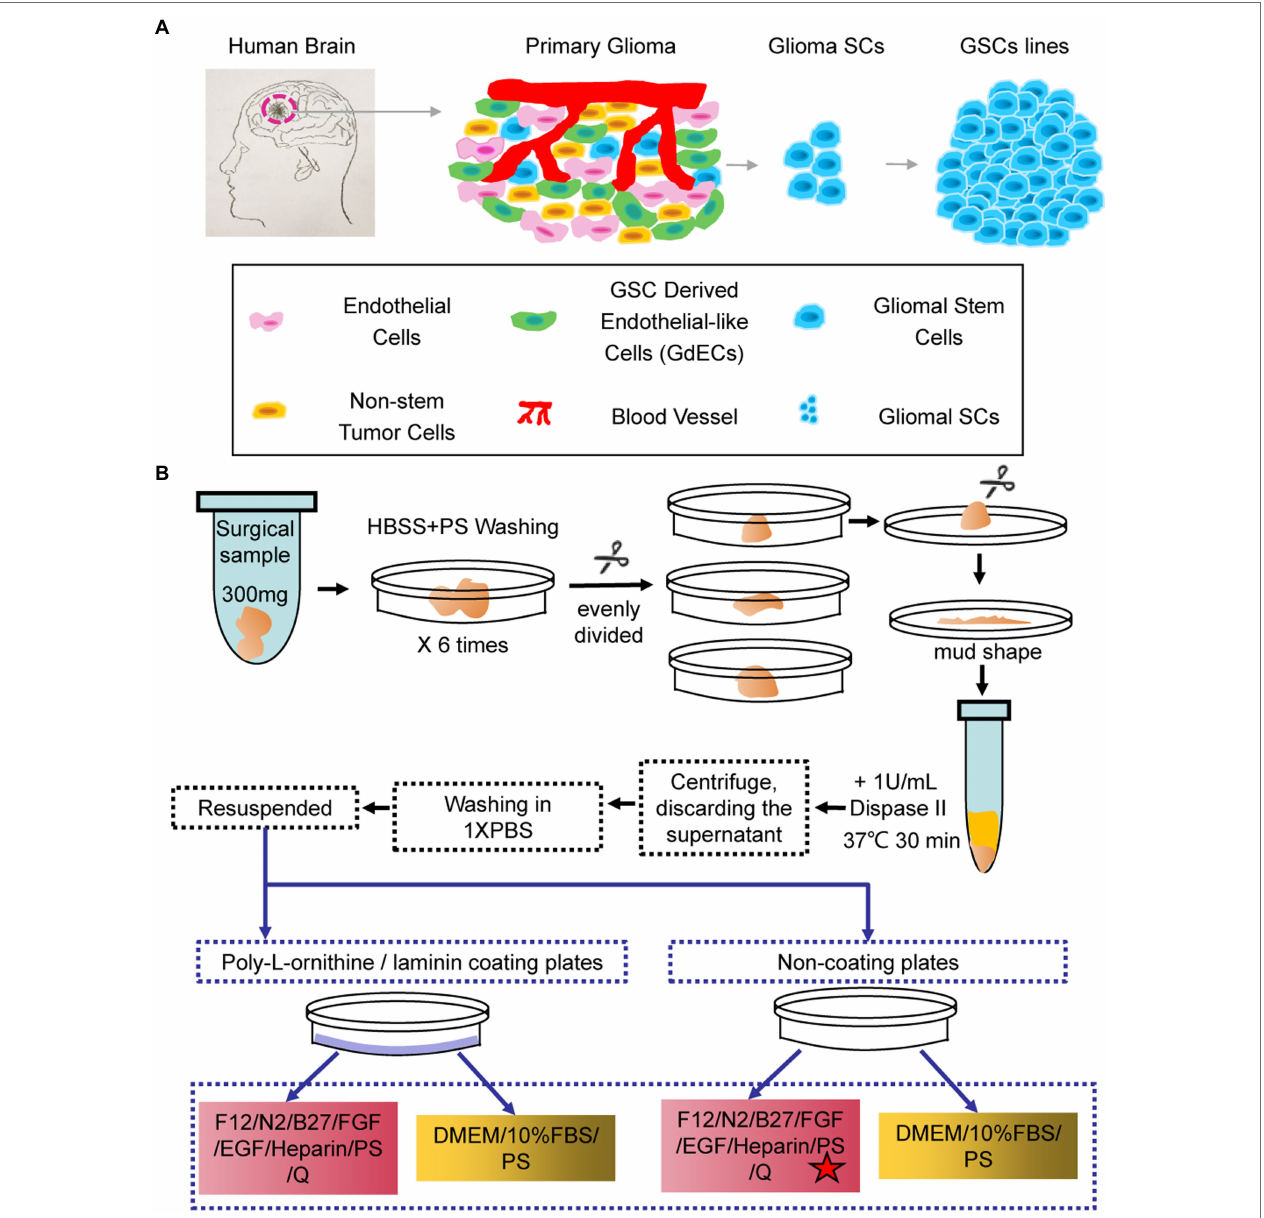
FIGURE 1 | Schematic and flowchart describing how human glioma stem cell (hGSC) culture was derived. (A) hGSC isolation from glioma tissue and removal of other cells, including endothelial cells, glioma stem cells (GSCs)-derived endothelial-like cells, and non-stem tumor cells. (B) hGSC derivation